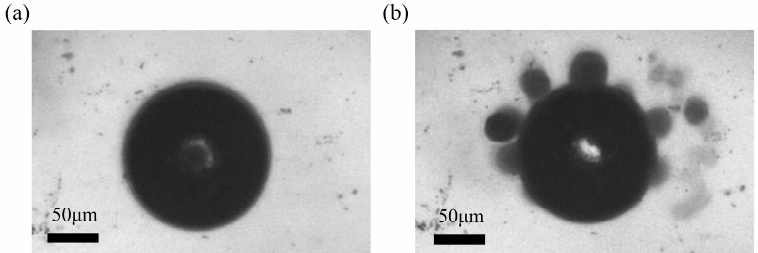
Figure 9. Collection of pandorina morums by an oscillated bubble. ( a ) No morums around the bubble when the piezo-actuator is off; ( b ) some morums are collected by the vibrating bubble. The frequency and amplitude of control signal is 8 kHz and 30 V. The diameter of bubble is about 130 μ m, and the diameter of the cells is 30 μ m. This collecting process takes five seconds.